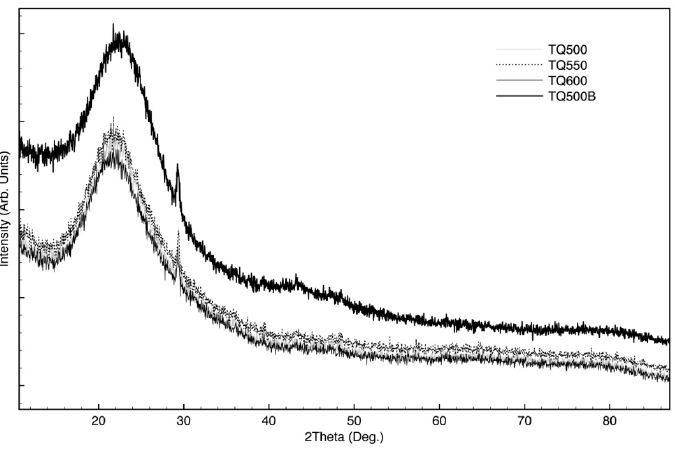
Figure 2. X ‐ ray diffraction analysis of TQ rice husk ashes treated at different temperatures (see Table 1).